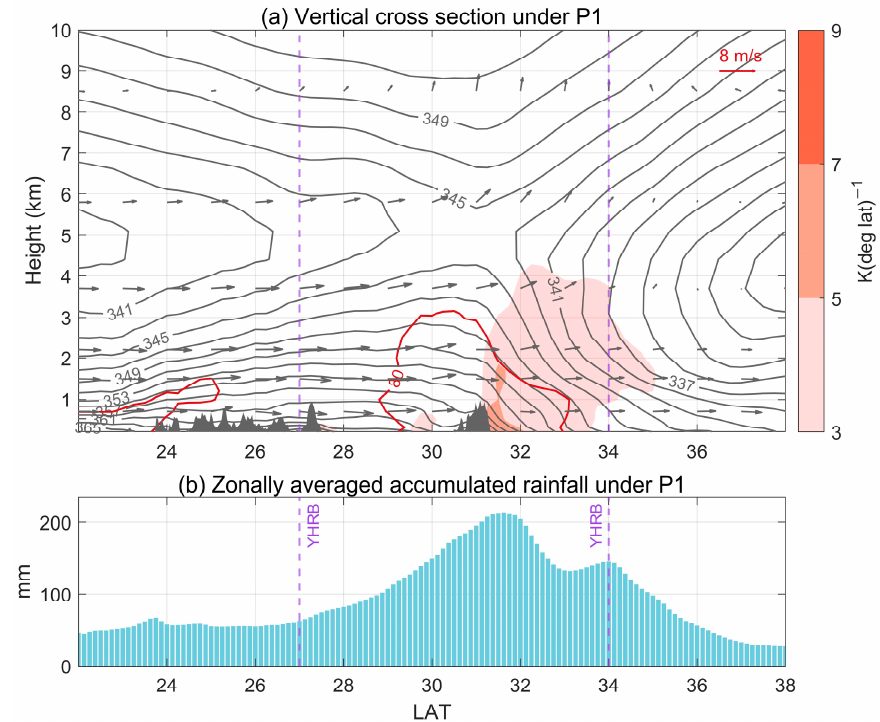
Figure 5. ( a ) The meridional-height (y, z) cross sections in the N–S direction of the equivalent potential temperature (black contours) and its equatorial gradient (shading; units: K (deg lat − 1 )) in-plane flow vectors (units: m s − 1 ), and the red contours of relative humidity in 80% and 90% along 116.25 ◦ E within the YHRB under the synoptic patterns of P1. The vertical purple dashed line at 27 ◦ N and 34 ◦ N denotes the latitudinal boundary of the study area in this paper. ( b ) The zonally averaged accumulated rainfall within the longitudinal boundary of the YHRB (111 ◦ E to 122 ◦ E) under the synoptic patterns of P1 along latitudes from 22 ◦ N to 38 ◦ N.